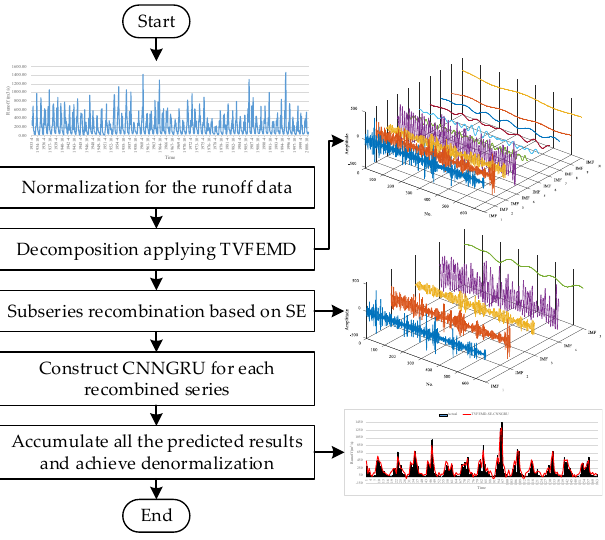
Figure 3. The flow chart of the proposed compound approach.